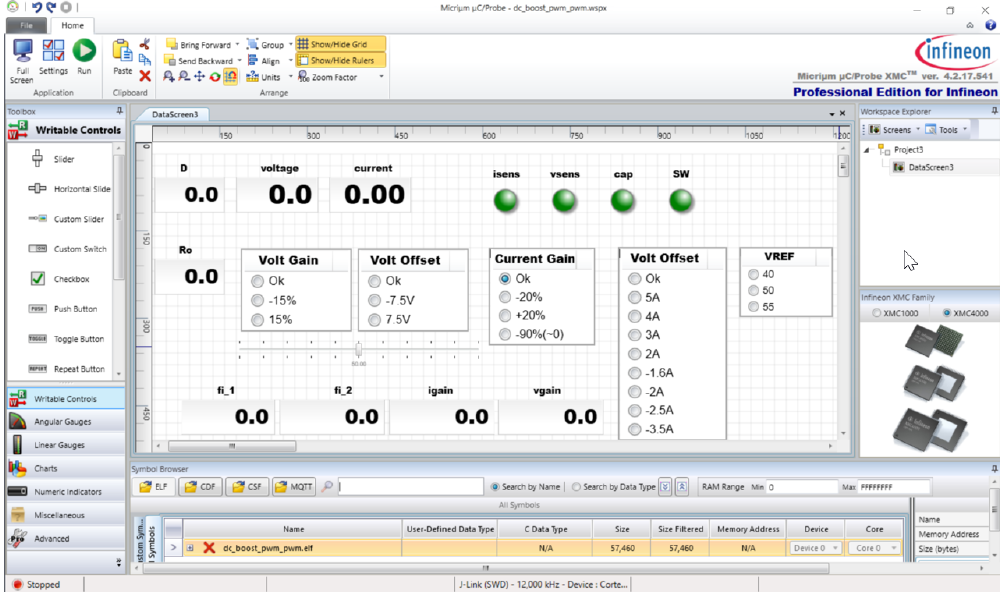
Figure 13. Micrium working